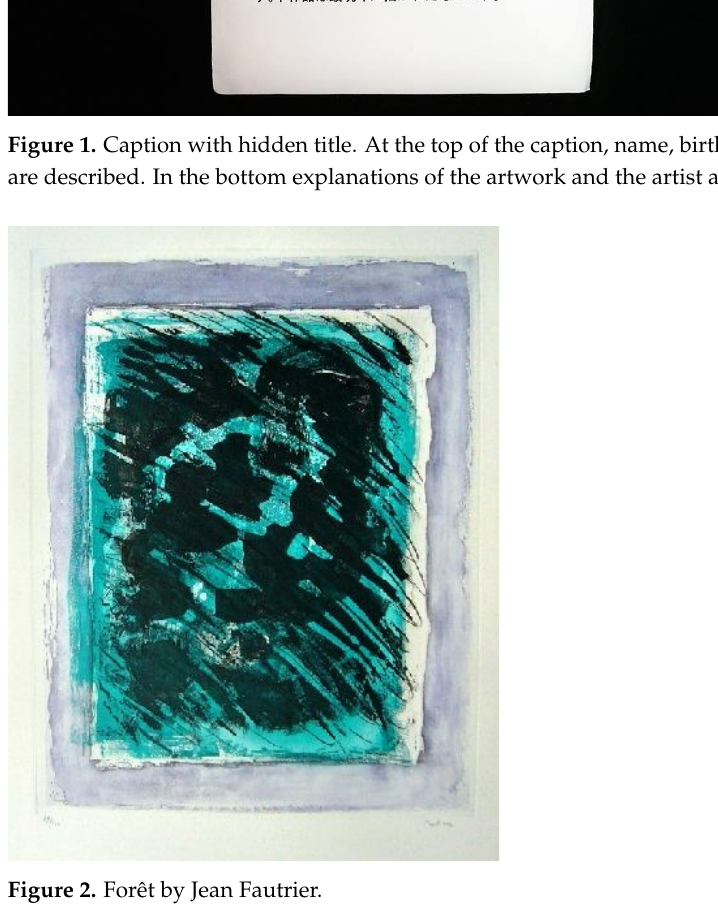
Figure 2. Forêt by Jean